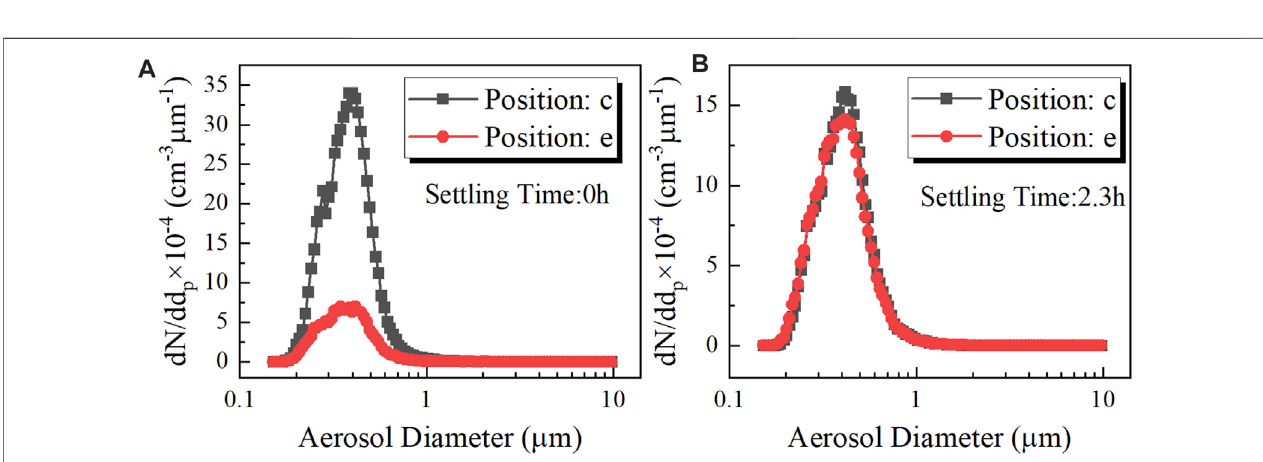
FIGURE 4 | Homogenization of the aerosol: (A) 0 h settling, (B) 2.3 h